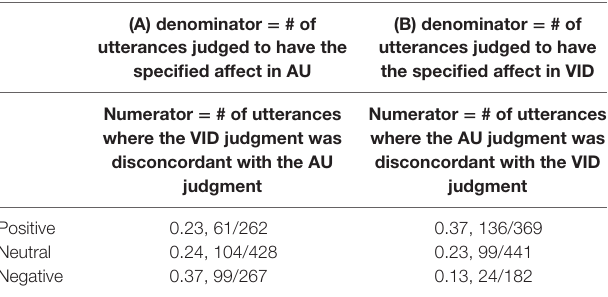
TaBle 2 | A presentation of proportions of cases where facial and vocal affect were not judged concordantly in AU and VID for each affect type. (a) denominator = # of (B) denominator = # of utterances judged to have the utterances judged to specified affect in aU